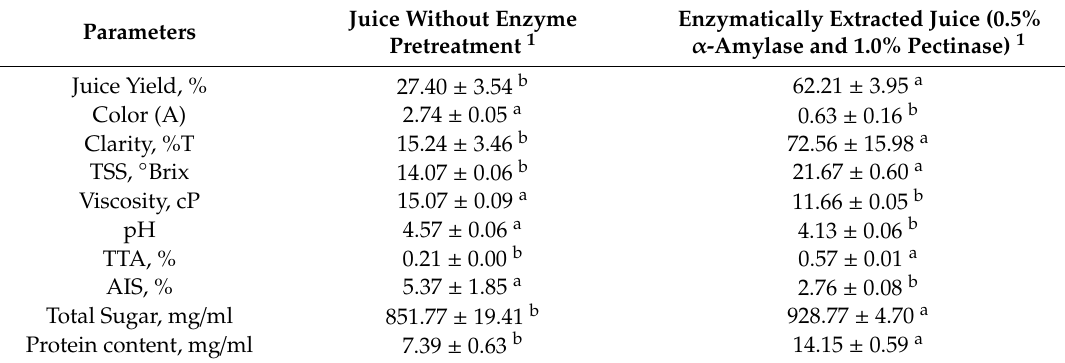
Table 2. Comparison of the physico-chemical properties of the ‘Saba’ banana juice extracted with and without enzyme